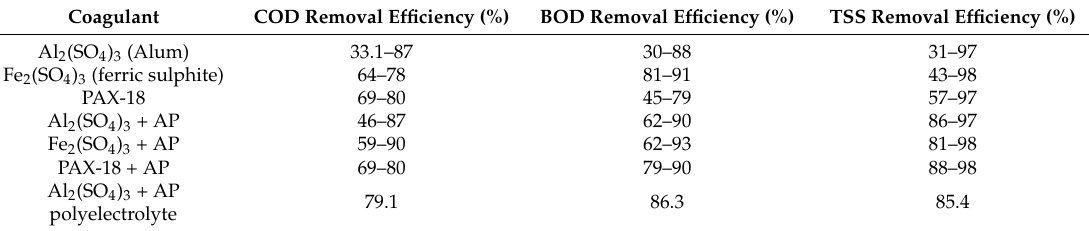
Table 9. Removal efficiencies of COD, BOD 5 and TSS using different coagulants [27]. Coagulant COD Removal Efficiency